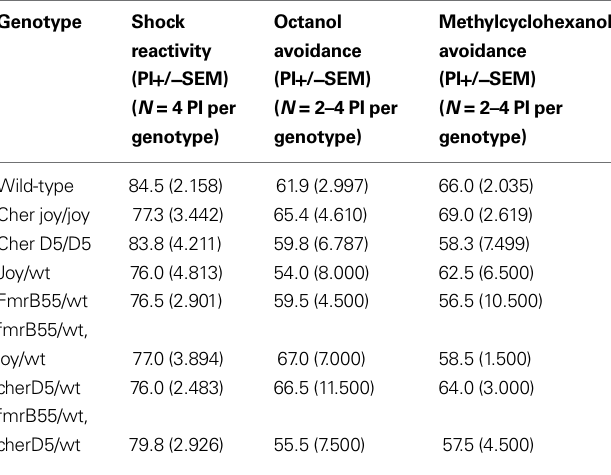
Table 1 | Sensorimotor responses are normal in various cher and dFmr1 genotypes.